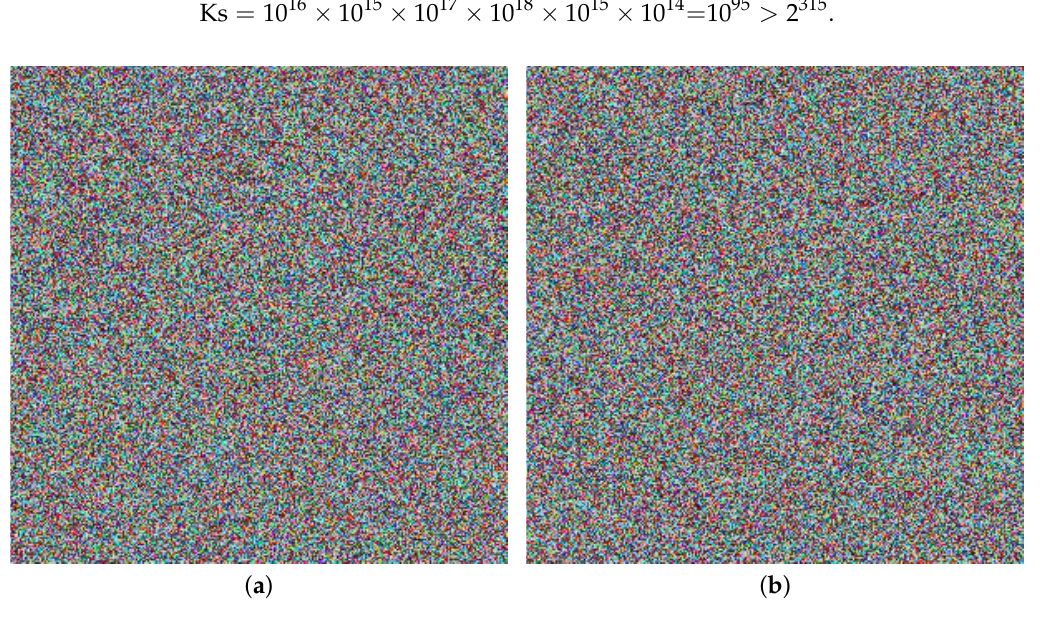
; ( b ) recovered image with parameter ρ (cid:48) . 0